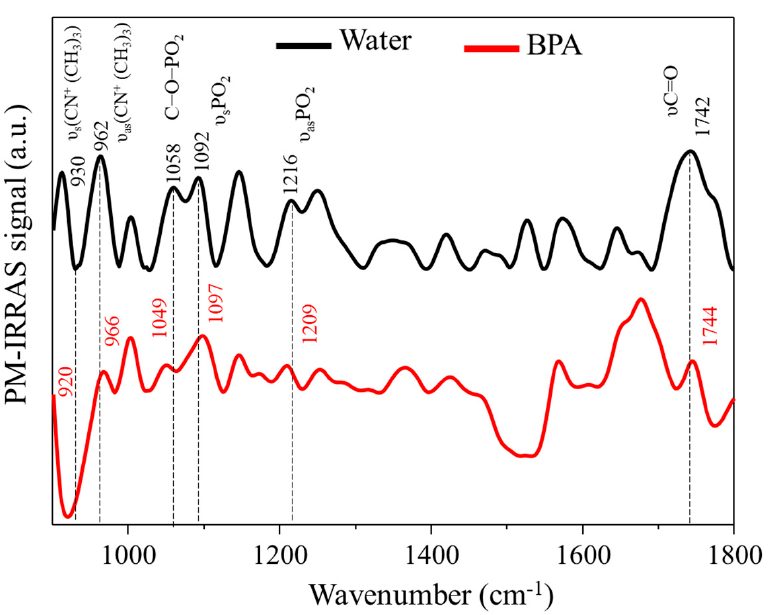
Figure 4. PM–IRRAS spectra from 900 to 1800 cm − 1 for the DPPC/cholesterol mixture (3:1) in the absence and presence of BPA (1 × 10 − 5 mol/L) obtained at room temperature (23 °C) and surface pressure of 30 mN/m.